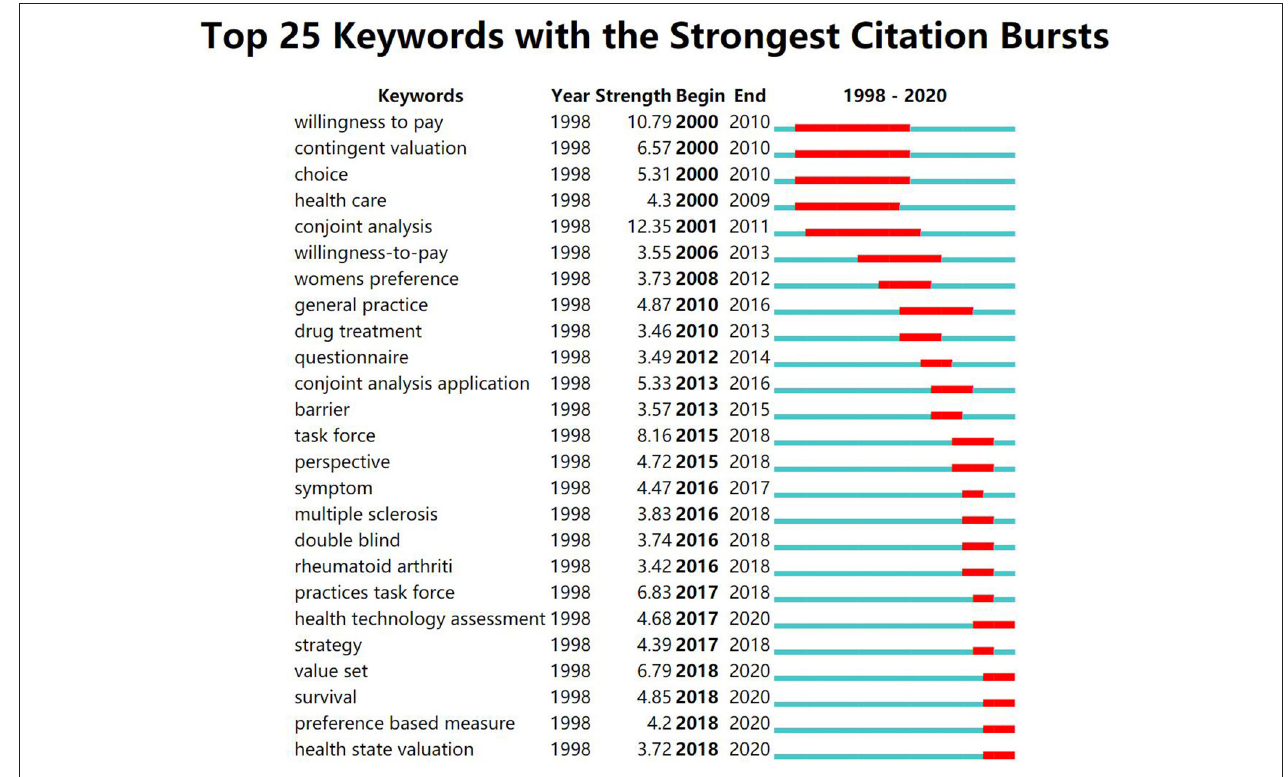
FIGURE 5 | The citation burst of discrete choice experiment (DCE) studies in health